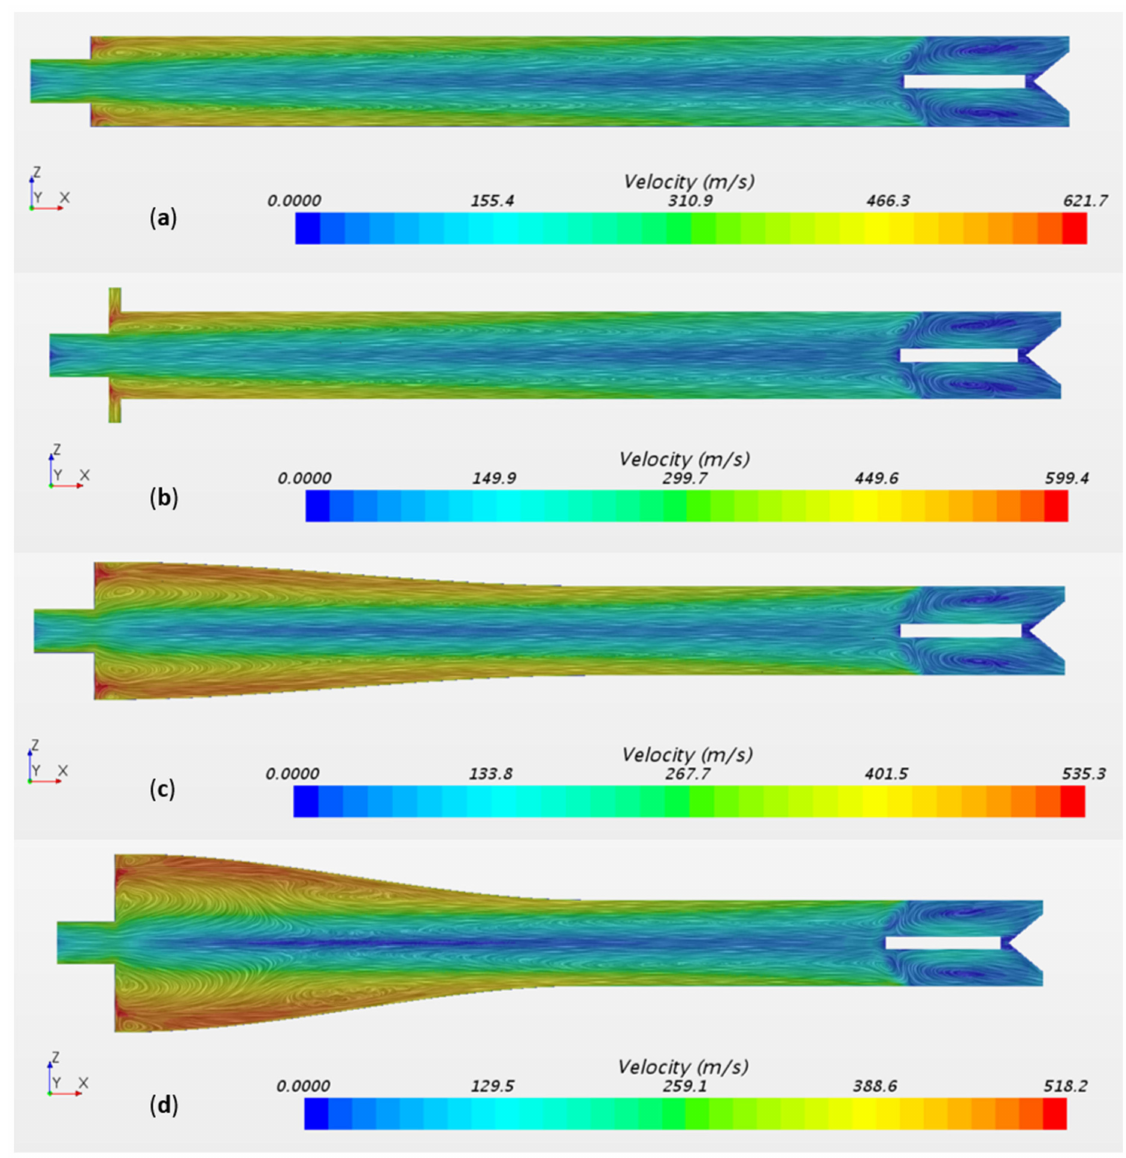
Figure 8. Flow patterns and total velocity magnitudes in the longitudinal planes: ( a ) case A, ( b ) case B, ( c ) case C, ( d ) case